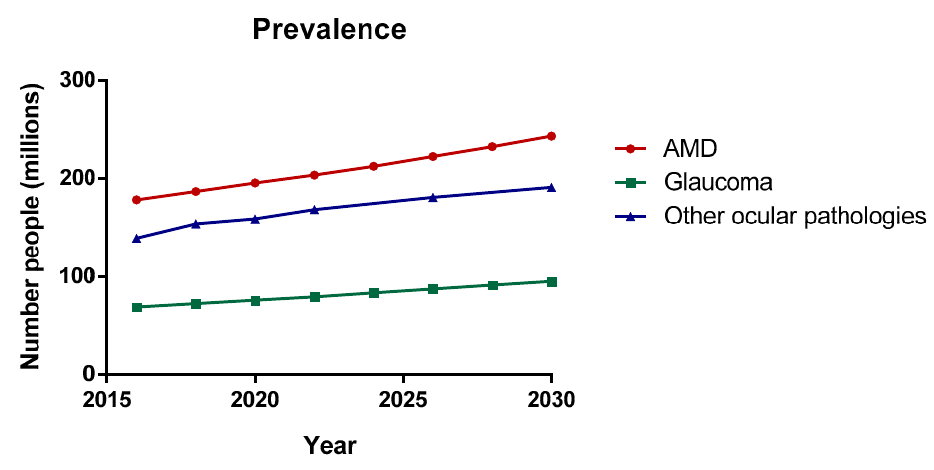
Figure 1. Prevalence of the main ocular pathologies. Data from the world report on vision published by the World Health Organization (WHO), 2019 [1].